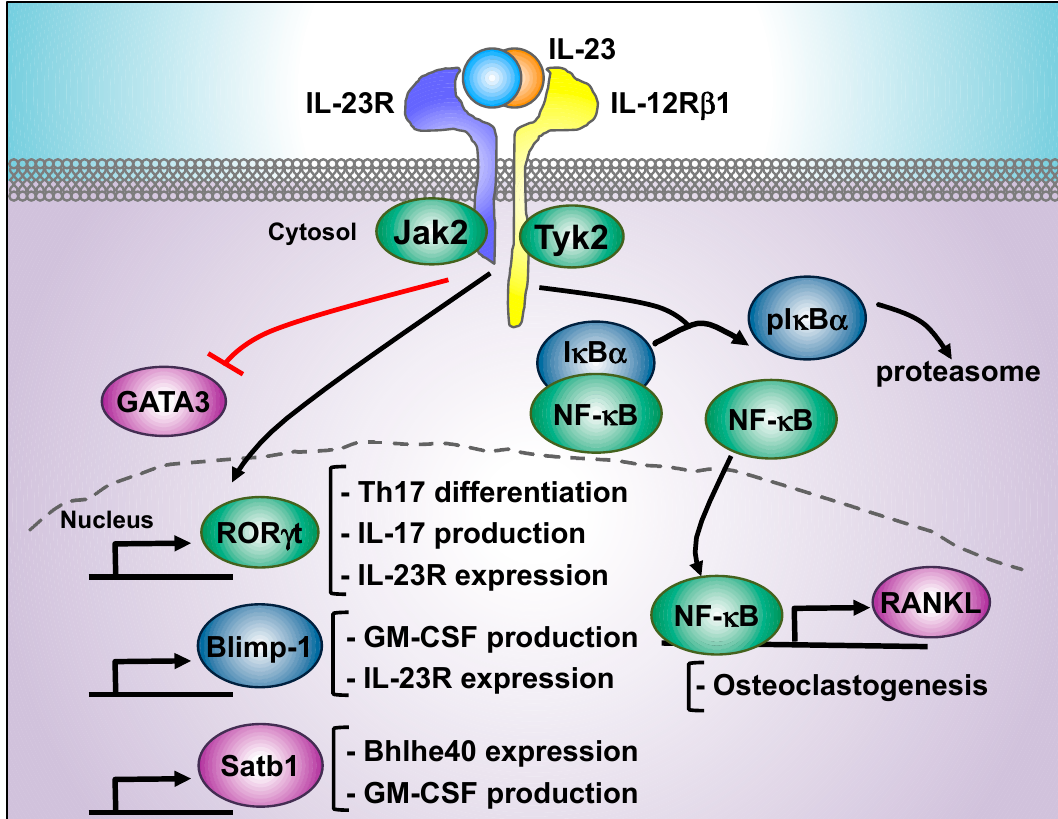
Figure 4. IL-23-regulated transcription factors. IL-23 induces the expression of the transcription factor retinoic acid receptor-related orphan receptor- γ t (ROR γ t), master regulator of Th17 cell differentiation and essential for IL-17 production and IL-23R expression. IL-23 promotes the expression of the transcription factor Blimp1, required for GM-CSF production and IL-23R expression in Th17 cells. IL-23 stimulation increases the expression of the chromatin organizer Satb1 that in turn promotes Bhlhe40 expression that are required for GM-CSF production. IL-23 promotes I κ B α phosphorylation and proteasomal degradation, allowing NF- κ B translocation to the nucleus and the induction of the receptor activator of NF- κ B ligand (RANKL) expression, a key osteoclastogenic cytokine involved in bone destruction and arthritis pathology.